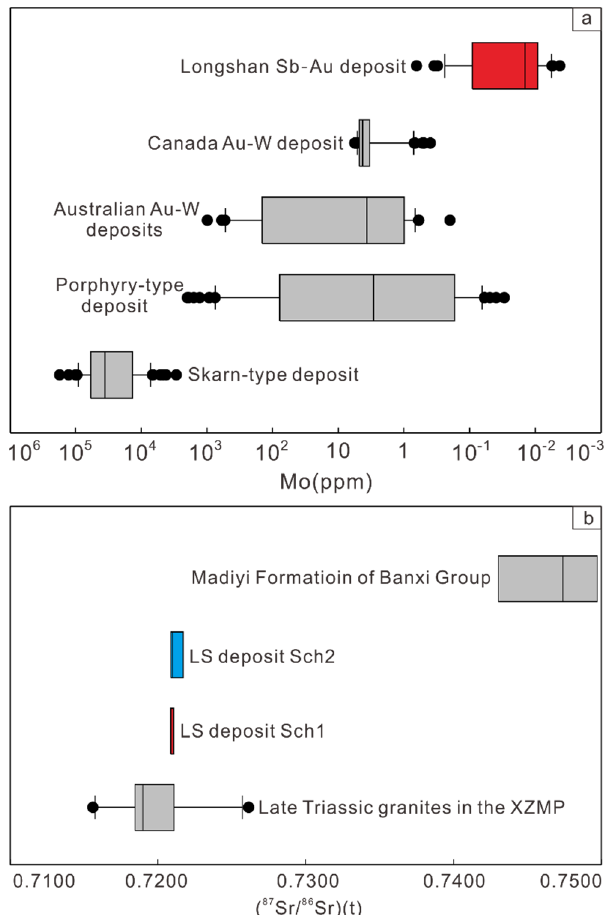
Figure 11. ( a ) Comparison of Mo content (ppm) in scheelite from different type of deposits; ( b ) Plot of 87 Sr/ 86 Sr ratios for scheelite from the from the Longshan Sb-Au deposit, South China. The ( 87 Sr/ 86 Sr) (t = 210 Ma) ratios for Late Triassic granites are from Gao et al. [41]. The ( 87 Sr/ 86 Sr)(t = 210 Ma) ratios for Banxi Group basement strata are from Peng and Frei [12].